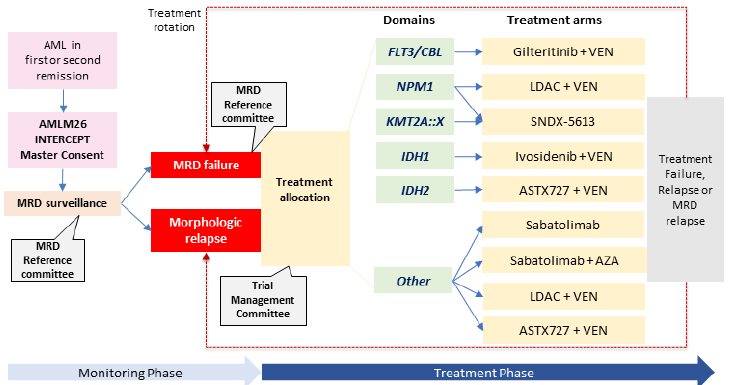
Figure 1. Trial schema of the AMLM26 INTERCEPT for MRD-directed therapy in AML. Abbreviations: AML, acute myeloid leukemia; AZA, azacitidine; LDAC, low dose cytarabine; MRD, measurable residual disease; and VEN, venetoclax.